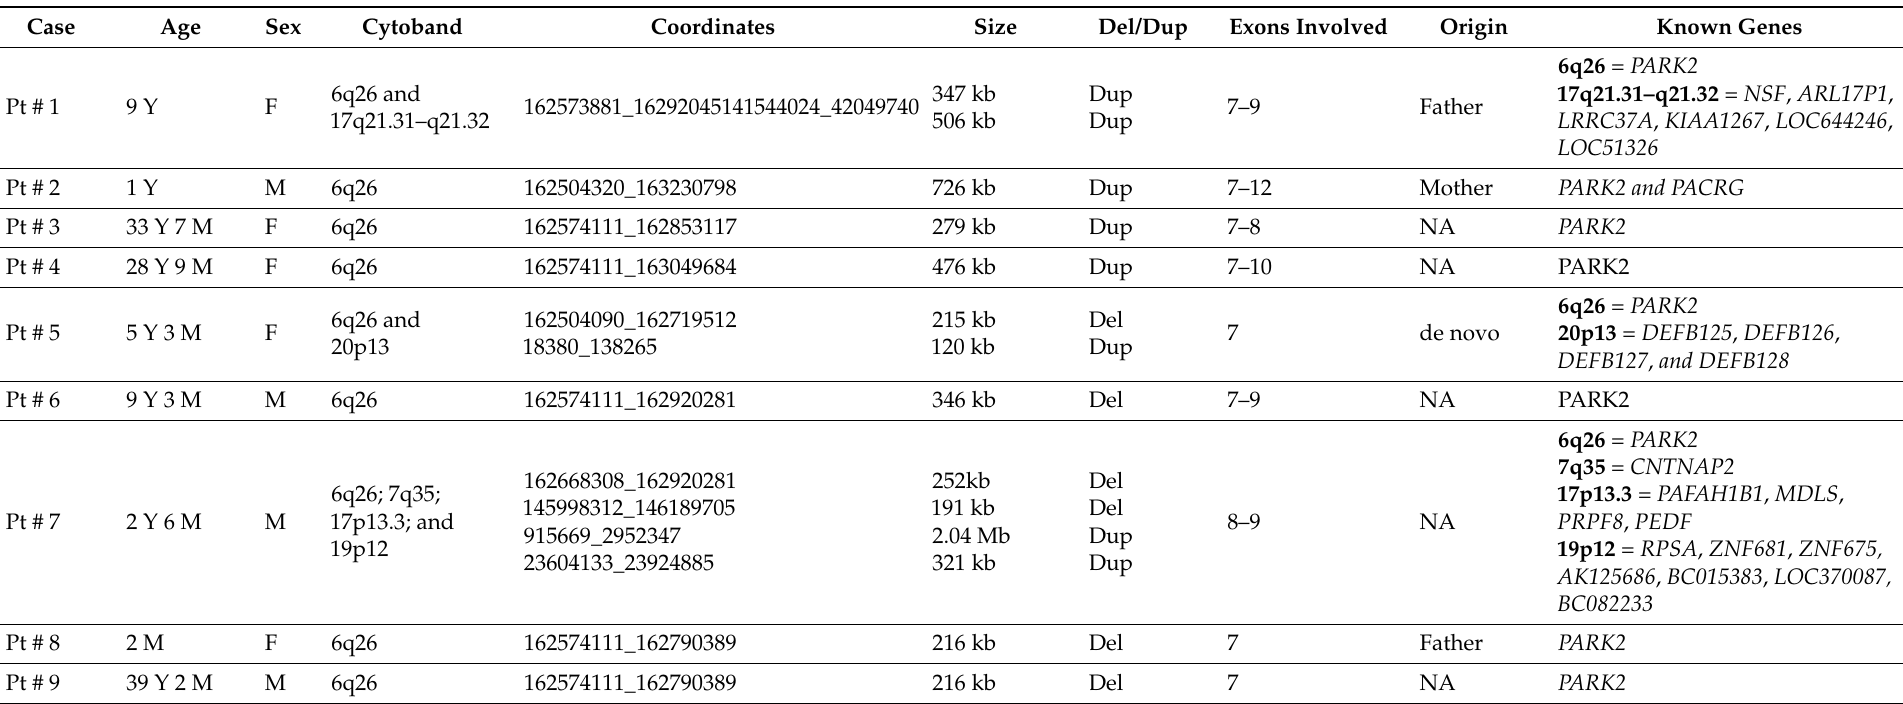
Table 3. Summary of the aCGH results of the nine